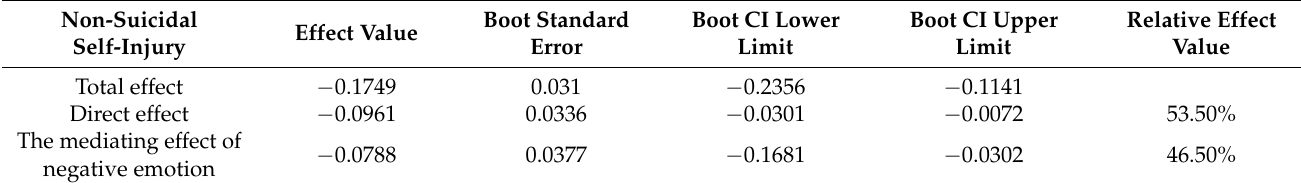
Table 2. Mediating role of negative emotions.